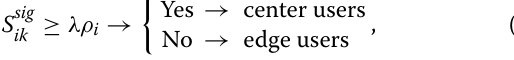
on user grouping, where the dashed area denotes edge area which meets the grouping